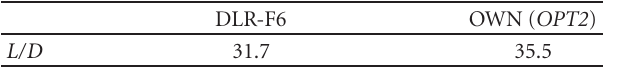
Table 4: Cruise performance of DLR-F6 and OWN ( OPT2 )